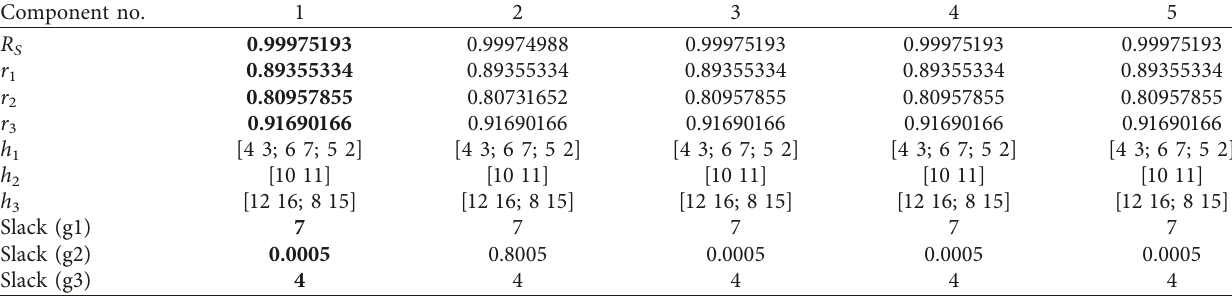
Table 16: Optimal component reliability and swapping strategy (Example 3).